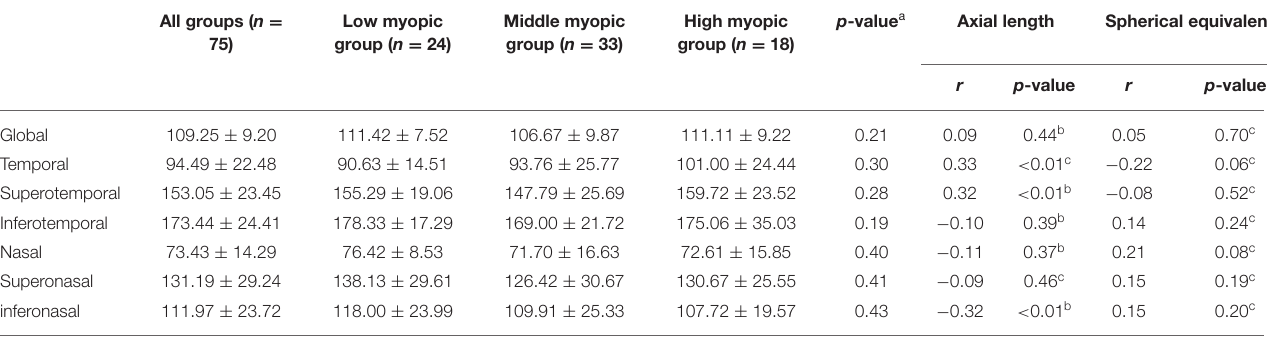
TABLE 4 | Diagnostic classification results of BMO-MRW and RNFL ( n = 75).